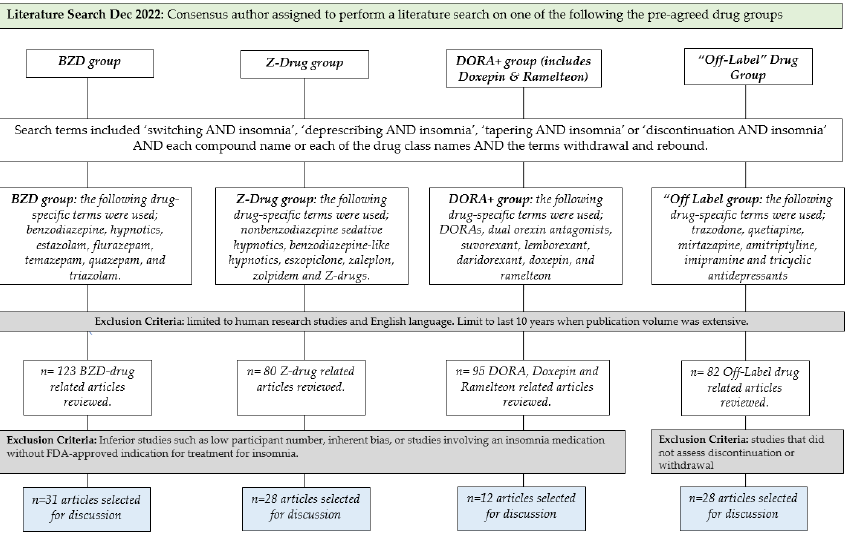
Figure 1. Flow chart summarizing the methodological approach utilized to generate reommenda- tions for best practices during insomnia medication transitions and medication